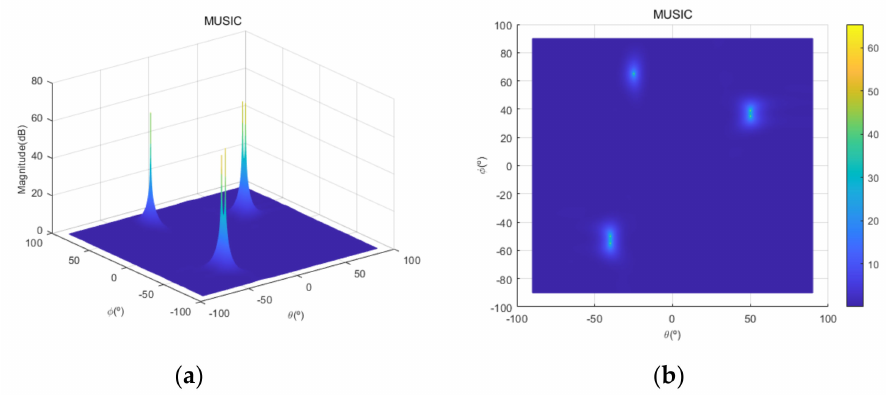
Figure 18. Spatial spectrum of MUSIC for the fourth scenario: ( a ) 3D, ( b ) top view ( θ = − 90 ◦ ∼ 90 ◦ , φ = − 90 ◦ ∼ 90 ◦ ).